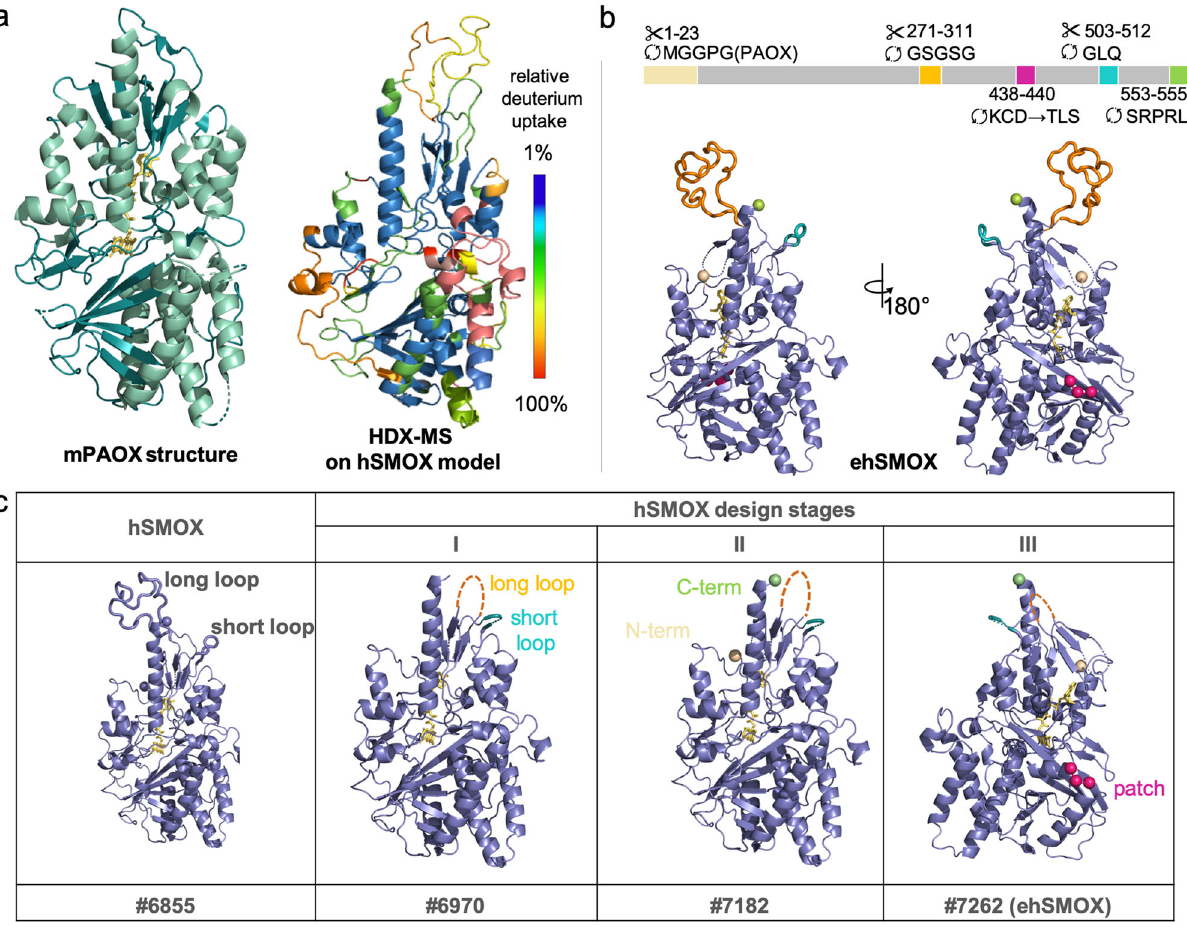
Fig. 2 hSMOX crystallography construct design. a Ribbon structure representation in green of mPAOX (PDB ID:5LEA) on the left and dynamic properties of hSMOX analyzed by HDX-MS on the right. The relative deuterium uptake illustrating the local dynamics of different structural units is depicted on hSMOX model using a color code from blue (1% deuterium uptake, protected) to red (100% deuterium uptake; disordered/ fl exible). b Front and back of engineered hSMOX with key modi fi cations depicted and color-coded. c Construct modi fi cations for each design stage depicted on ribbon hSMOX model structure and